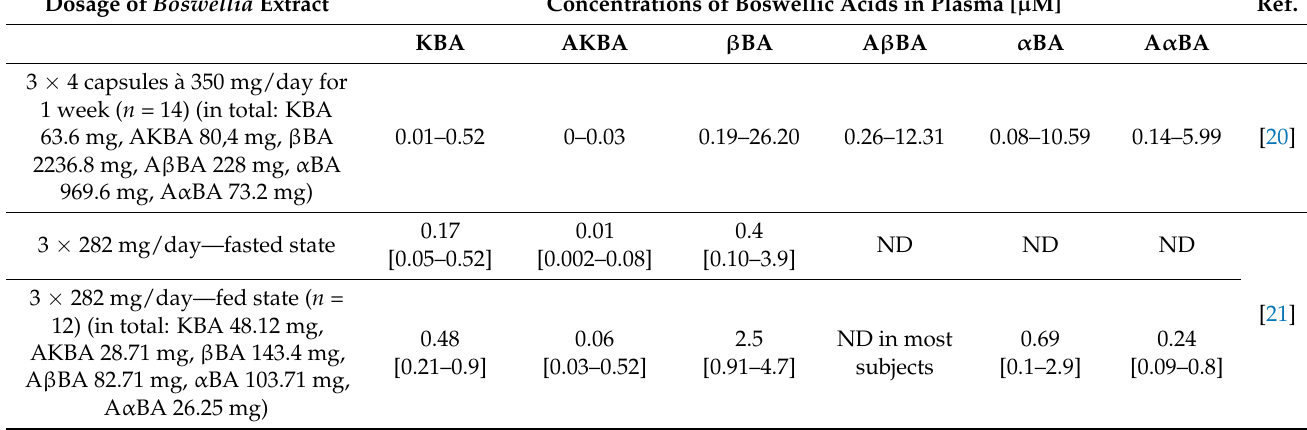
Table 1. Overview on the plasma concentrations reported for the individual boswellic acids in pharmacokinetic studies carried out on at least six humans. Dosage of Boswellia Extract Concentrations of Boswellic Acids in Plasma [ µ M]